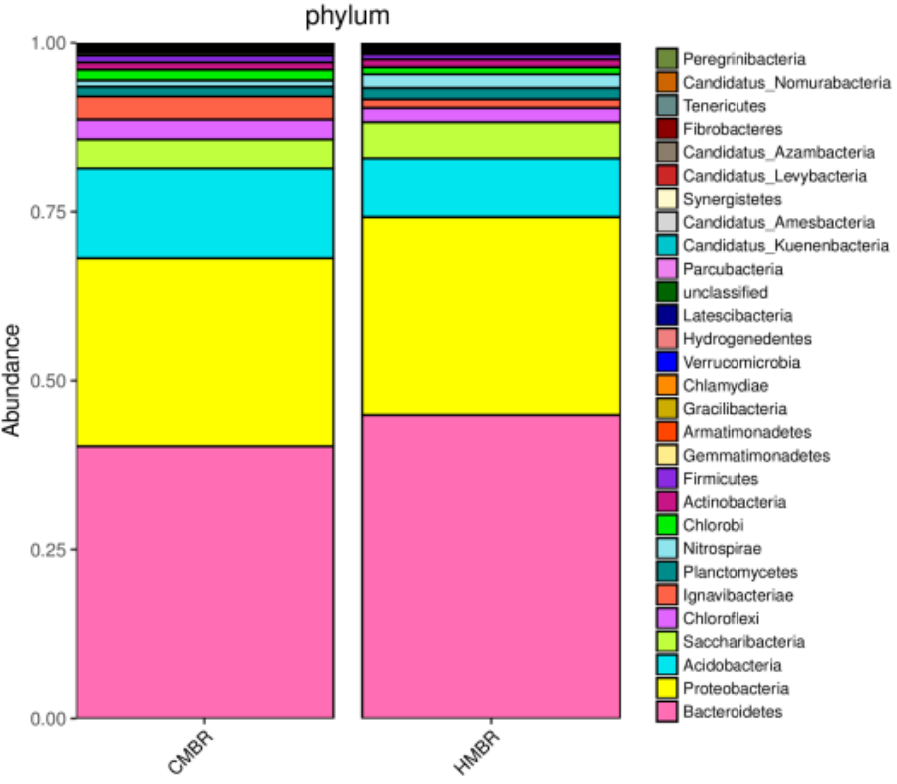
Figure 6. The microbial community structures of activated sludge in CMBR and HMBR at phylum level.